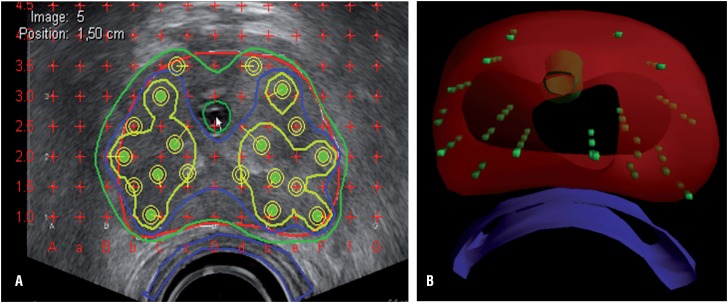
Left: Image of intra-operative planning on transrectal ultrasound. The colored lines mark the different areas where the radiation dose is similar. Urethra and rectum are marked to keep the radiation dose as low as possible in these regions. Right: 3D reconstruction of the seeds after implantation.